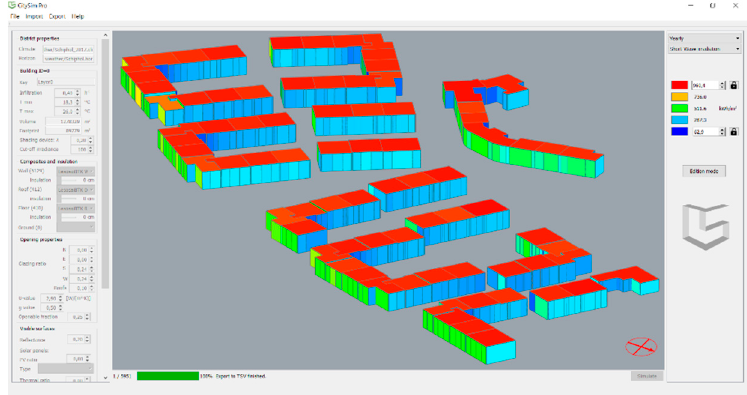
Figure 4. CitySim platform. Completion of energy simulation for an island.